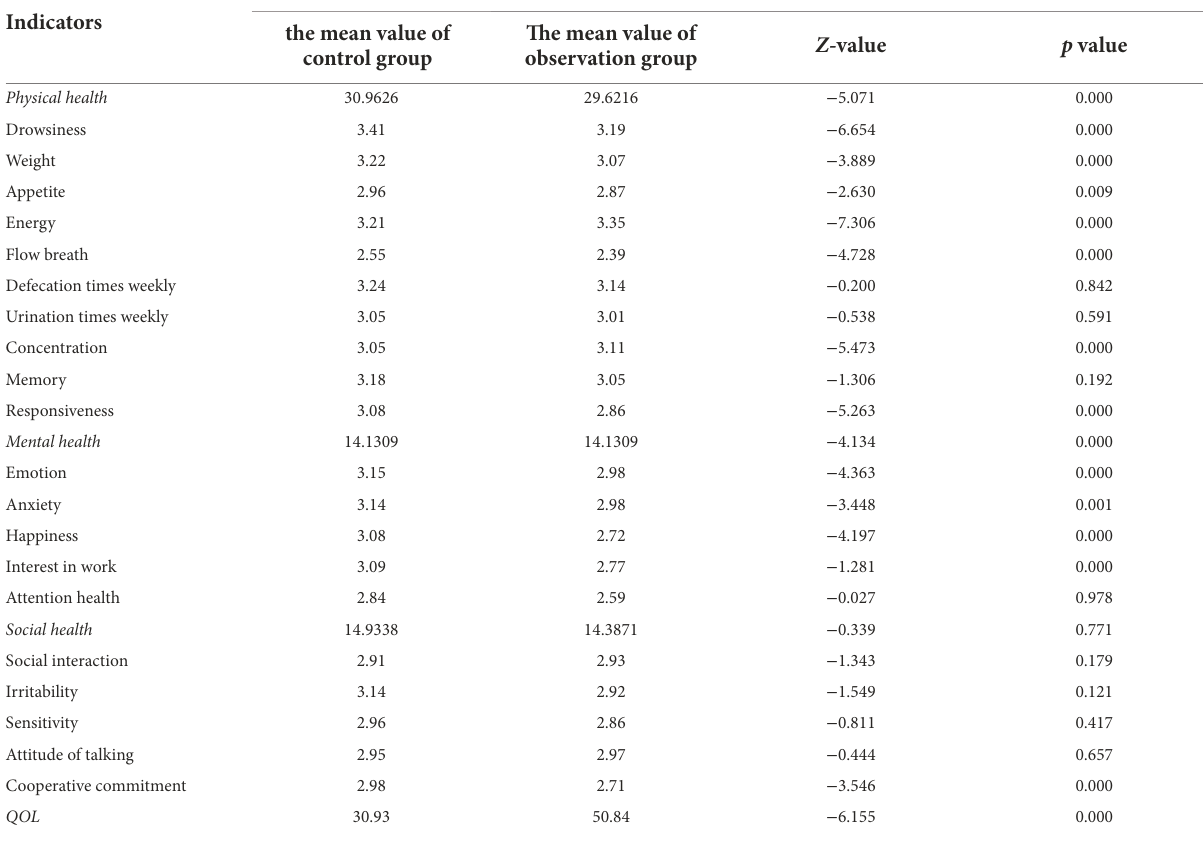
TABLE 5 Difference test statistics between observation group and control group a ( n = 695). Observation group and control group Pre-test and post-test were paired with Wilcoxon test Indicators the mean value of The mean value of control group observation